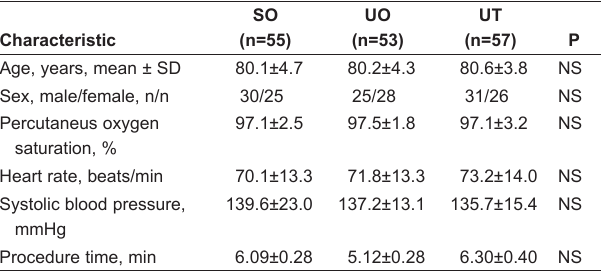
Table 1 Patient characteristics and baseline cardiopulmonary parameters in the study